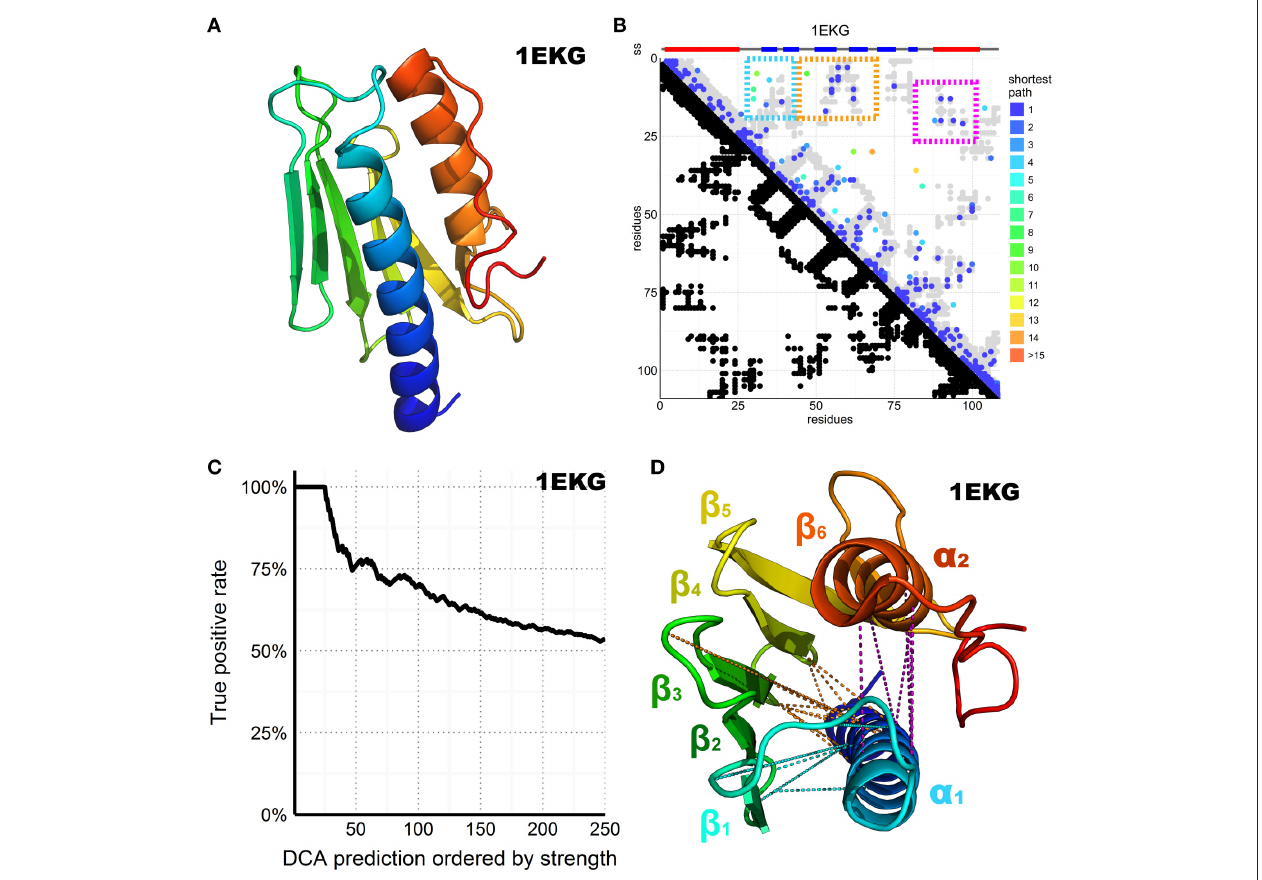
FIGURE 2 | DCA prediction of interacting residues in the CyaY/frataxin family. (A) CyaY / frataxin reference structure 1EKG. (B) Above the plot colored small rectangles indicate the secondary structure (ss) elements reported in the PDB structure and realigned to match the residues in the graph below. Beta sheets are painted blue while helices are red. The residue number of the family consensus sequence from the N- to the C-terminus is displayed on both axes. In the bottom half of the plot, black dots are used to indicate residues in contact in the 1EKG reference structure. In the top half of the plot, the predicted DCA contacts are colored according to the shortest path between residues in the structural contact map (Malinverni et al., 2015) (see also Supplementary Material). The gray dots are the same as shown in black in the bottom half but plotted again to help visualization. The three major clusters are highlighted by colored frames. (C) Plot of the DCA accuracy as a function of the top-scoring residues considered. The plot shows the normalized frequency of reference-matching predictions (number of matching hits divided by the number of prediction considered up to that point) vs. the DCA pairs sorted by strength. (D) 1EKG structure with the three main DCA predicted cluster contacts. In cyan, the α 1 –ß 1 ß 2 cluster; in orange, the α 1 –ß 3 ß 4 cluster; in purple, the α 1 – α 2 cluster. DCA predictions between residue pairs separated by less than five positions along the chain were ignored in the count of top scoring residues to favor long-range contact interactions but are shown in the plot to help